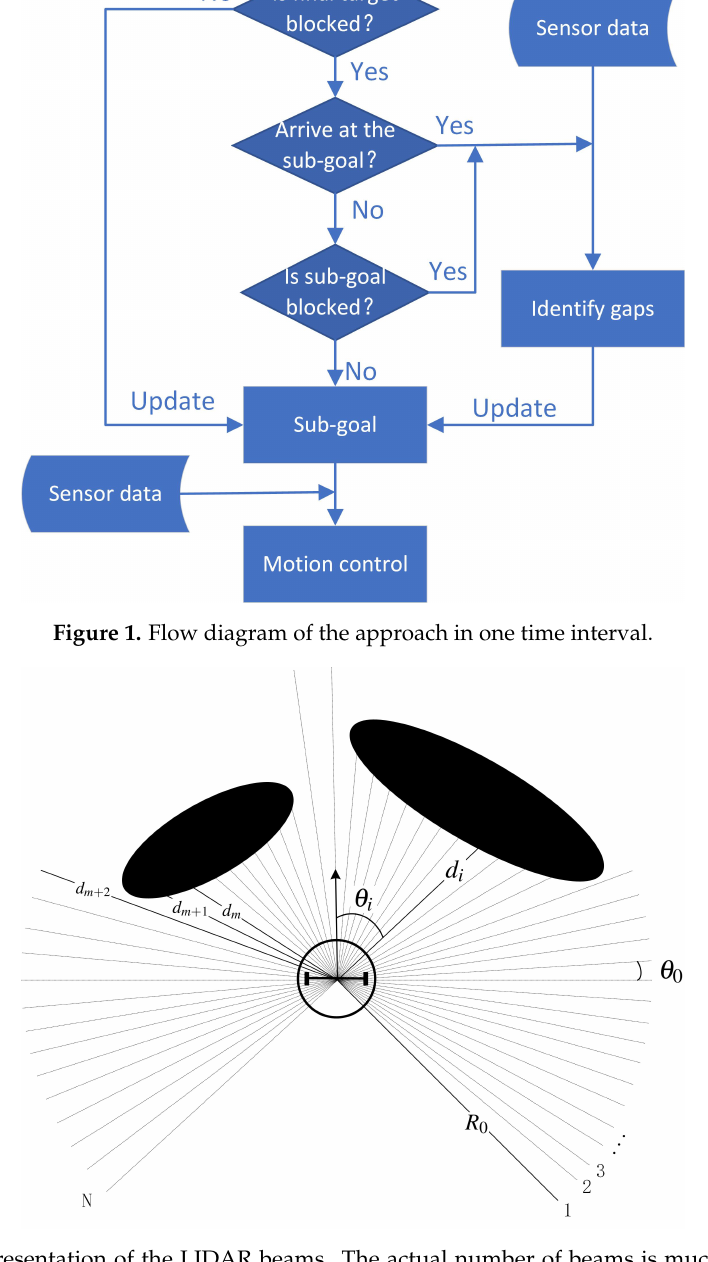
Figure 2. Representation of the LIDAR beams. The actual number of beams is much greater than illustrated